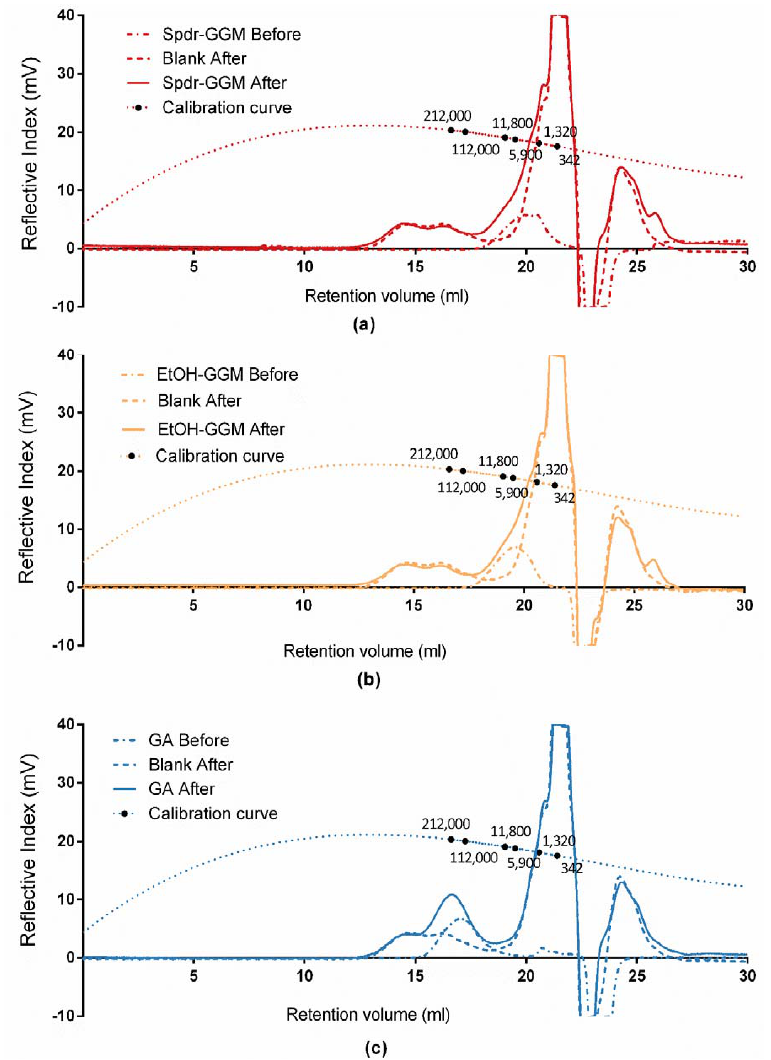
Figure A2. Size exclusion chromatograms of ( a ) Spdr ‐ GGM, ( b ) EtOH ‐ GGM, and ( c ) GA before and after in vitro digestion.